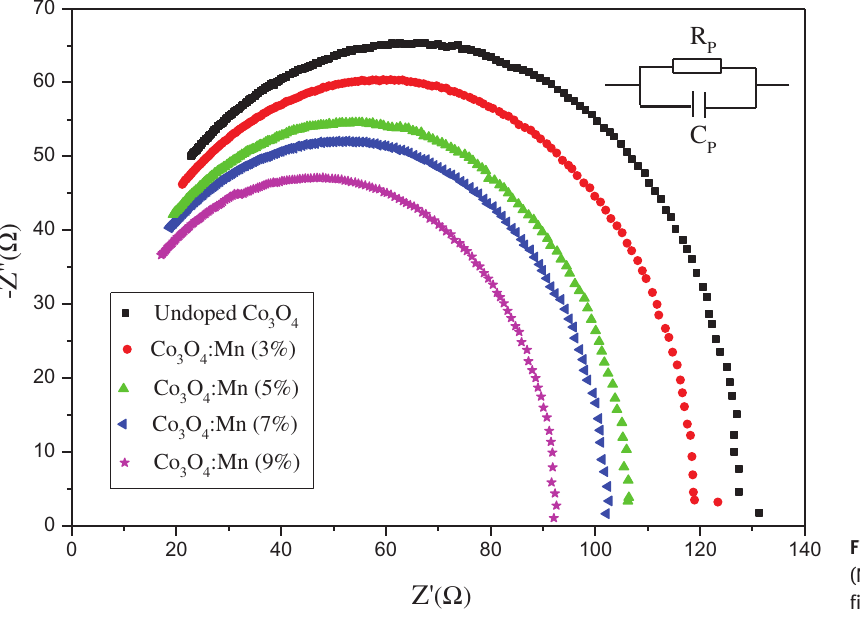
Figure 10: Complex impedance spectrum (Nyquist plots) of Mn-doped Co 3 O 4 thin films.